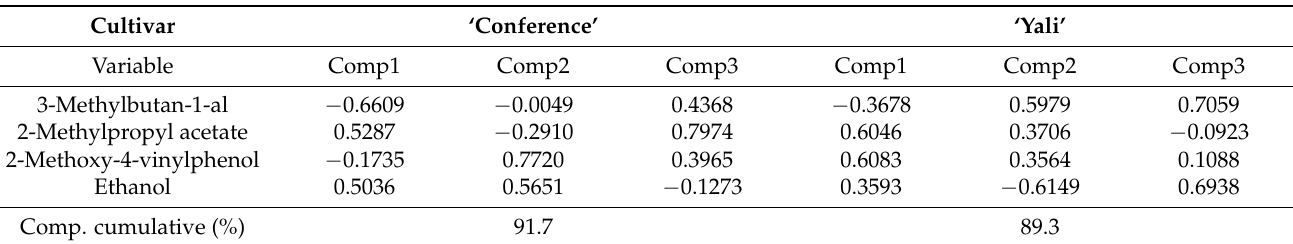
Table 3. Eigenvalues of the first three principal components and their cumulative value distinguishing the different storage regimes of pear cultivars ‘Conference’ and